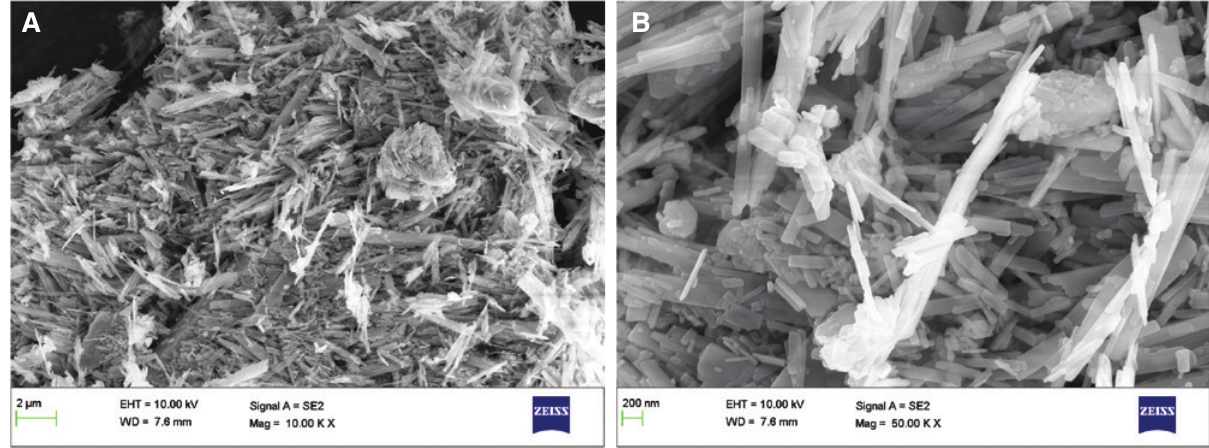
Figure 4: SEM images of 3D nanostructures of as-prepared MnNPs.